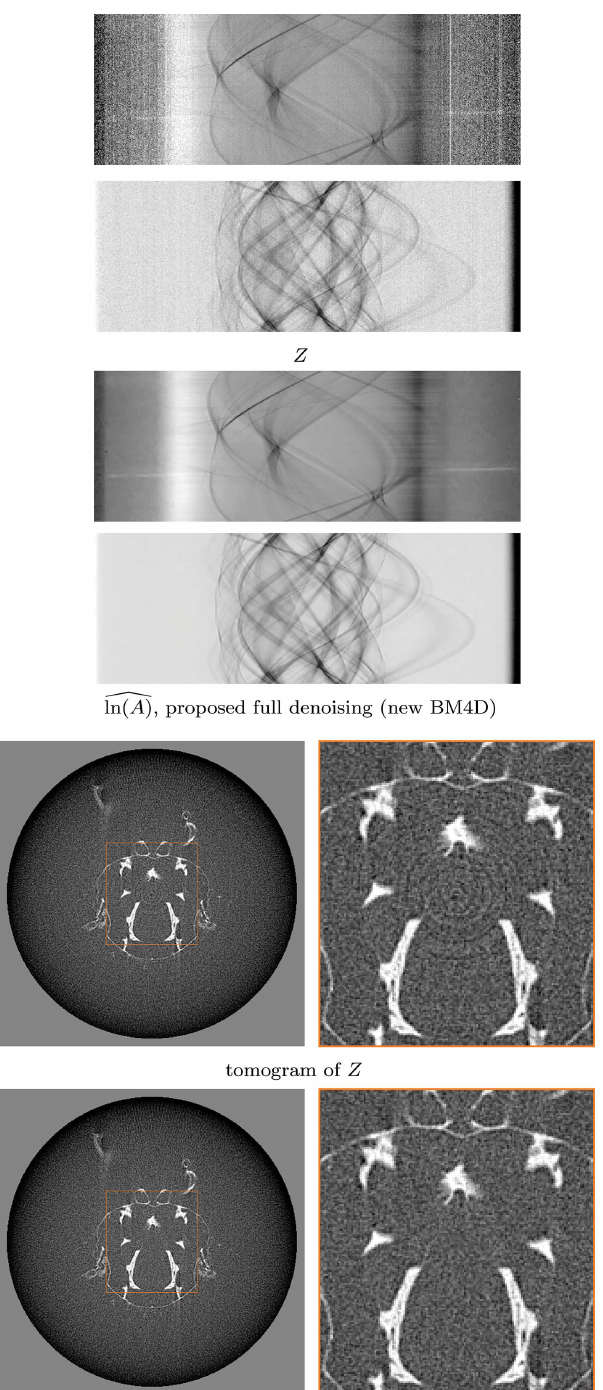
Figure 6 Denoising of the stack of projections of Fly , showing two sinograms of the noisy stack of projections Z (4) and the corresponding estimates d ln ð A Þ ln ð A Þ of the underlying stack of projections ln( A ) (3) obtained with the proposed framework (top), and the tomograms of the second sinogram (bottom), obtained with filtered back-projection using cone-beam geometry (Feldkamp et al. , 1984), for both the noisy data Z and the proposed estimate ^ YY of the streak-free projections Y (5). The tomogram for d ln ð A Þ ln ð A Þ is shown in Fig. 8. The first sinogram shows significant model nonstationarity in both streaks and the Poissonian component due to the